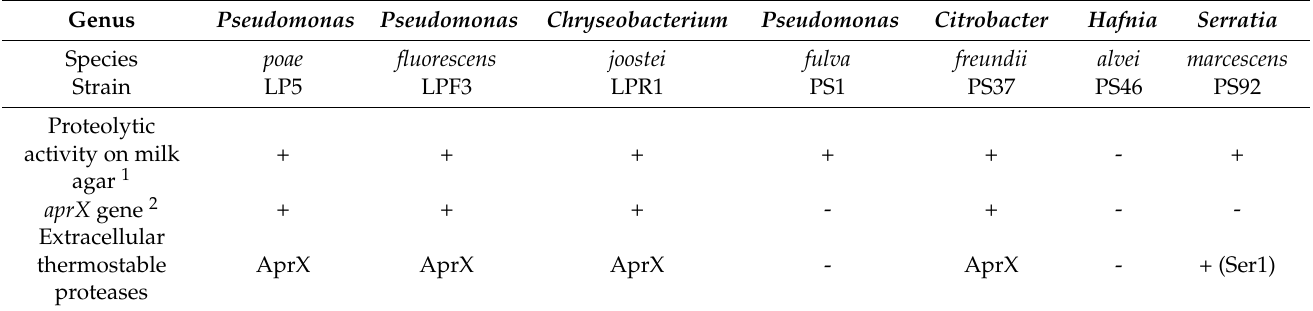
Table 1. Genotypic and phenotypic traits of the psychrotrophic